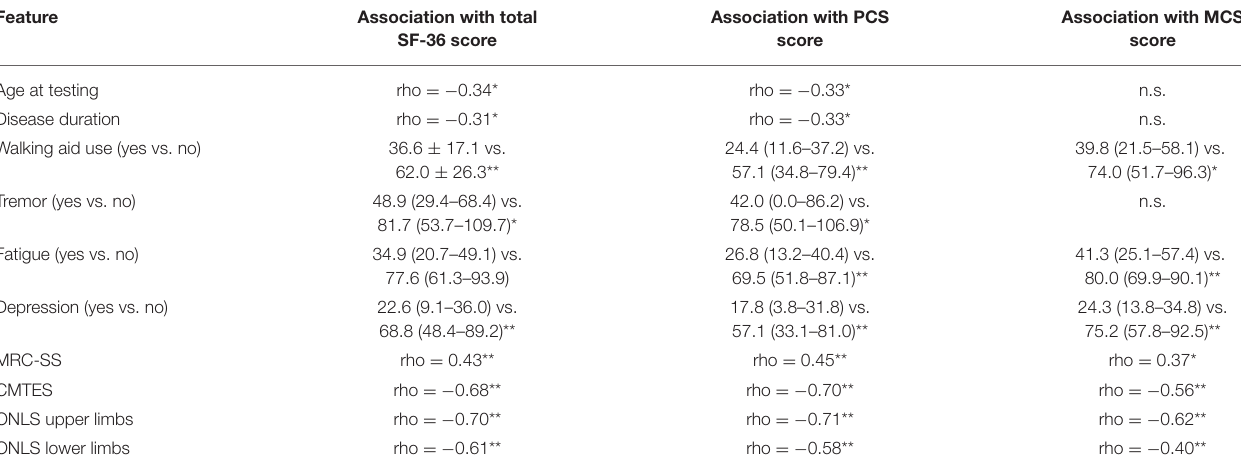
Association with PCS Association with MCS SF-36 score score score